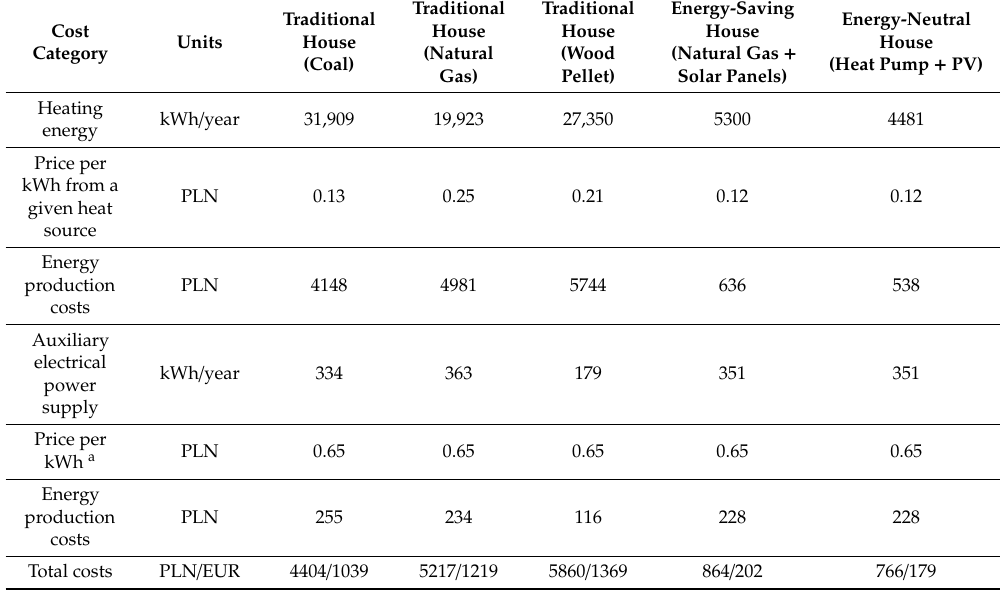
Table A1. Annual heating energy needs, energy production costs, auxiliary electricity needs and total costs for a rural detached residence central heating